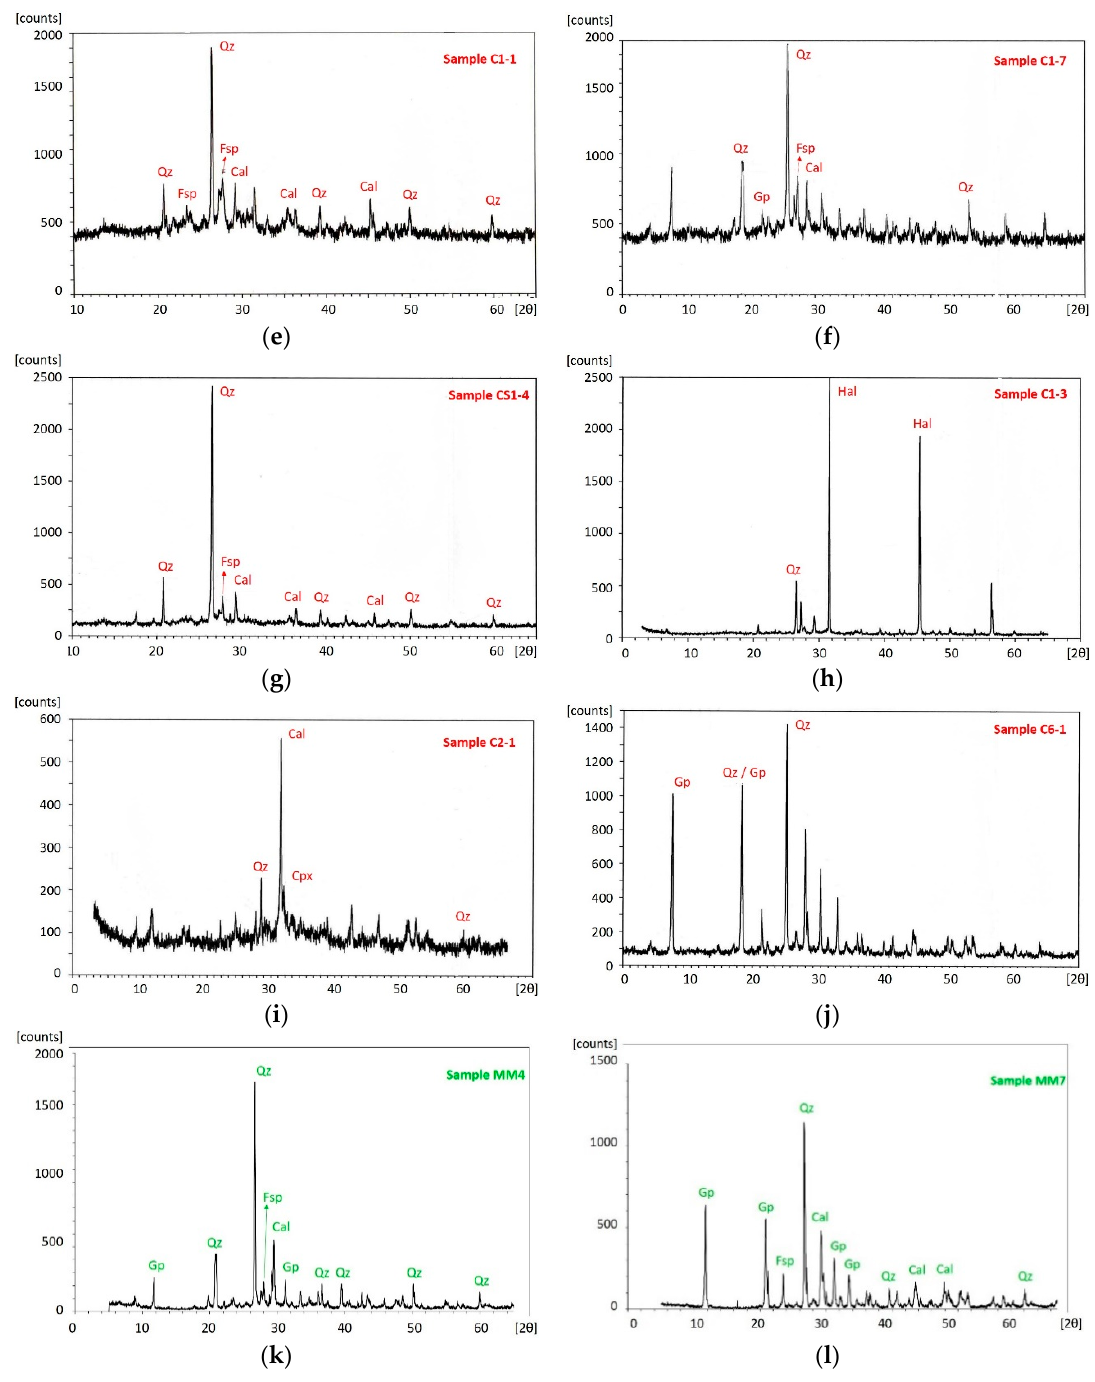
Figure 5. XRPD spectrums of the samples analyzed collected in (I) Palazzo Roverella: ( a ) R6 (flower decoration), ( b ) R9 (brick), ( c ) R16 (plaster), ( d ) R2 (plaster); (II) cloister of Santa Maria delle Grazie: ( e ) C1-1 (cotto), ( f ) C1-7 (cotto degraded), ( g ) CS1-4 (mortar), ( h ) C1-3 (saline efflorescence from the cotto sample C1-3c), ( i ) C2-1 (black crust), ( j ) C6-1 (sulphated black crust); (III) church of San Andrea: ( k ) MM4 (brick), ( l ) MM7 (plaster).